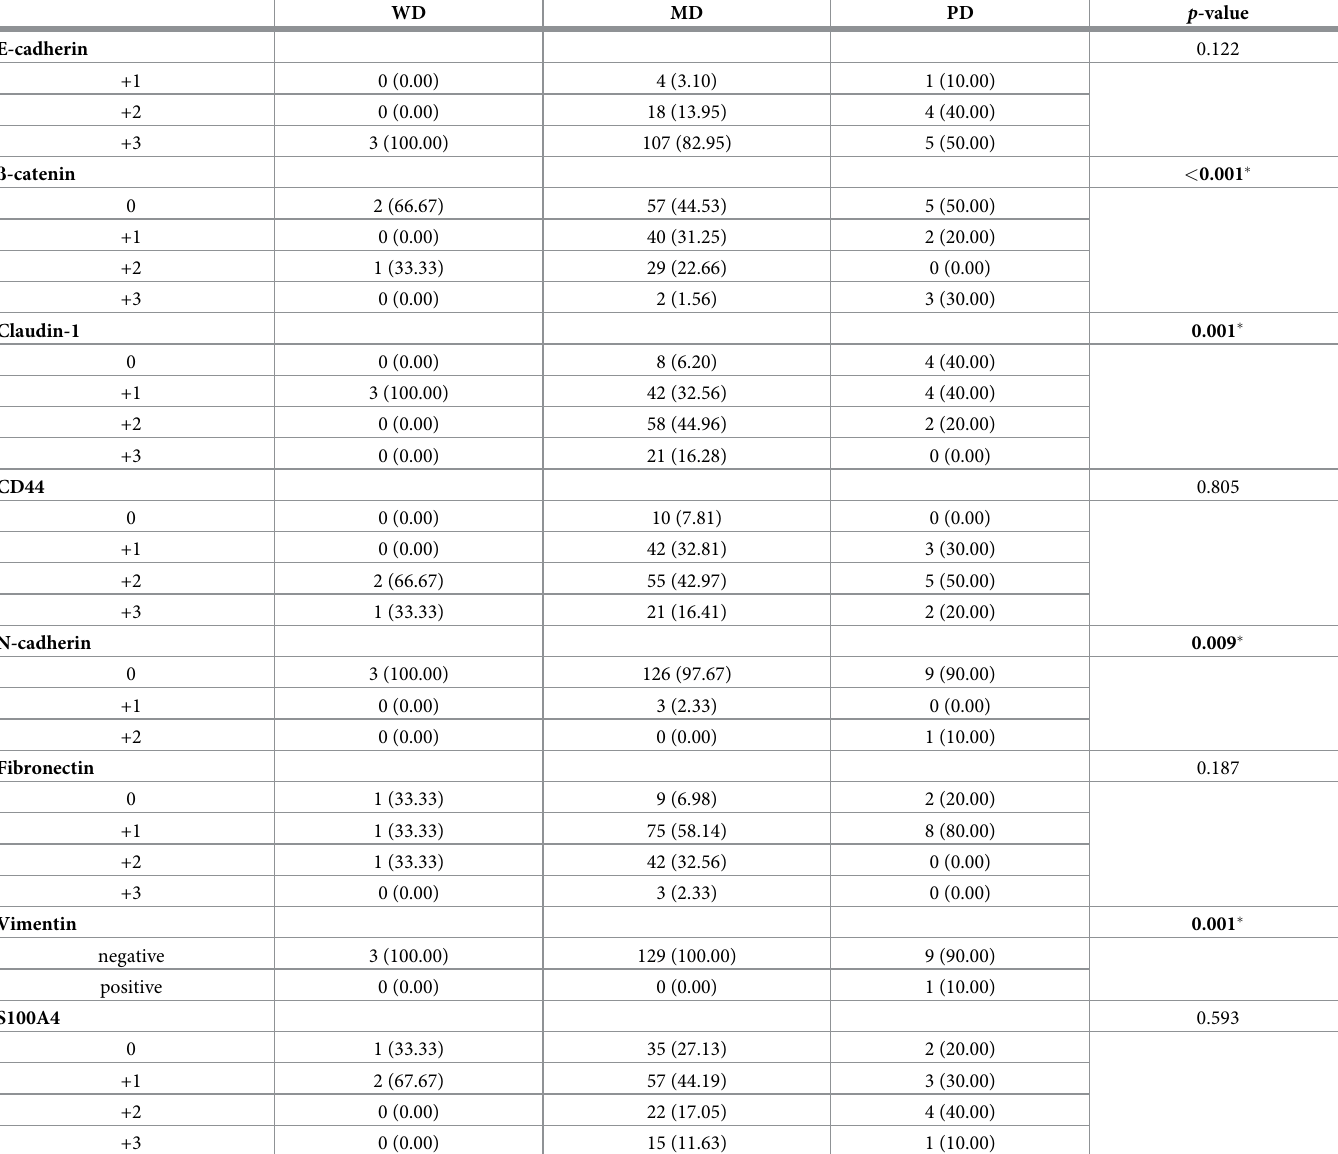
Table 3. IHC expression of EMT-related markers vs . histopathologic